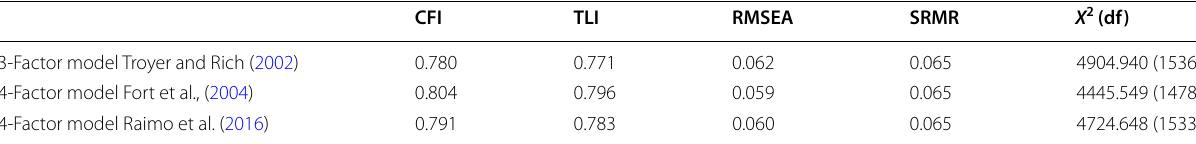
Table 2 Summary of 3-factor model and 4-factor